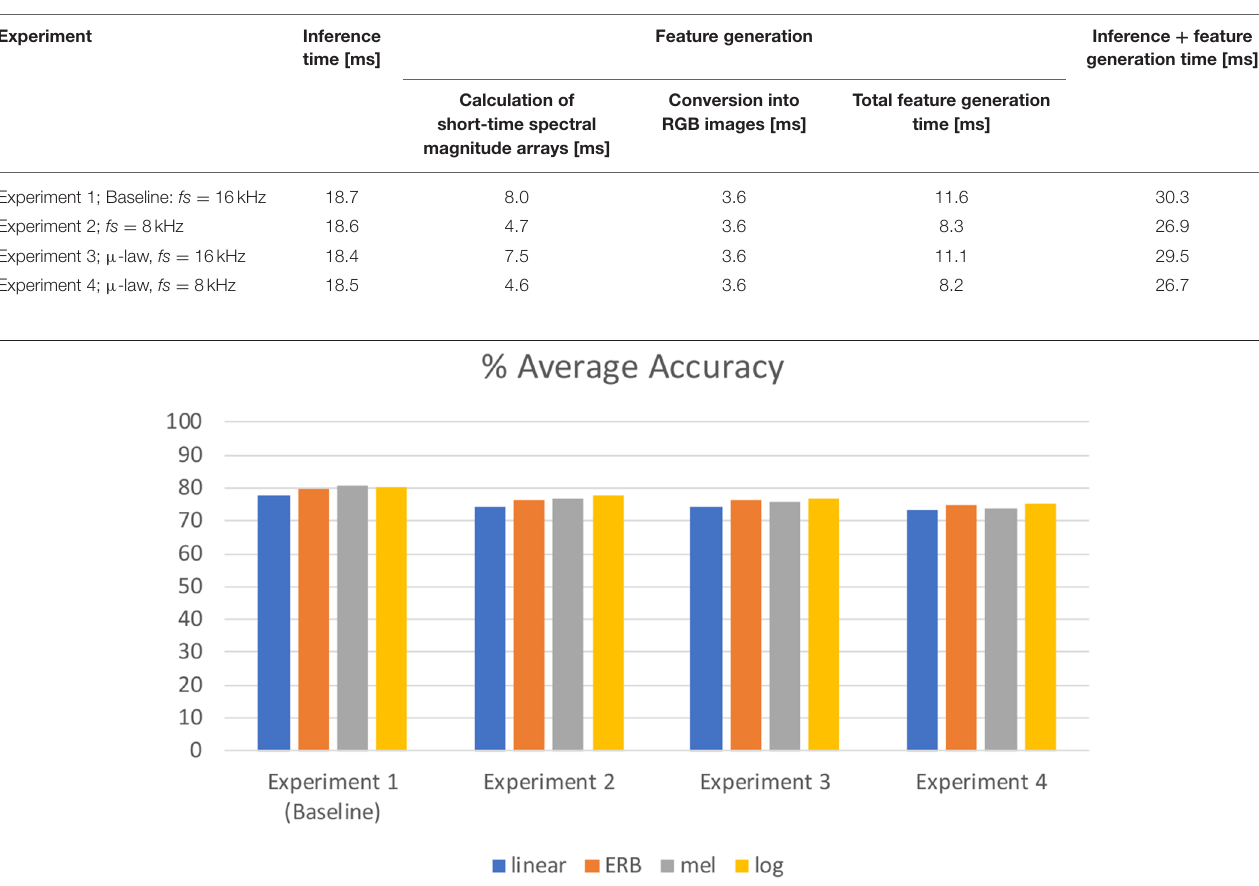
due to a shorter time needed to calculate magnitude spectrogram arrays. The addition of the